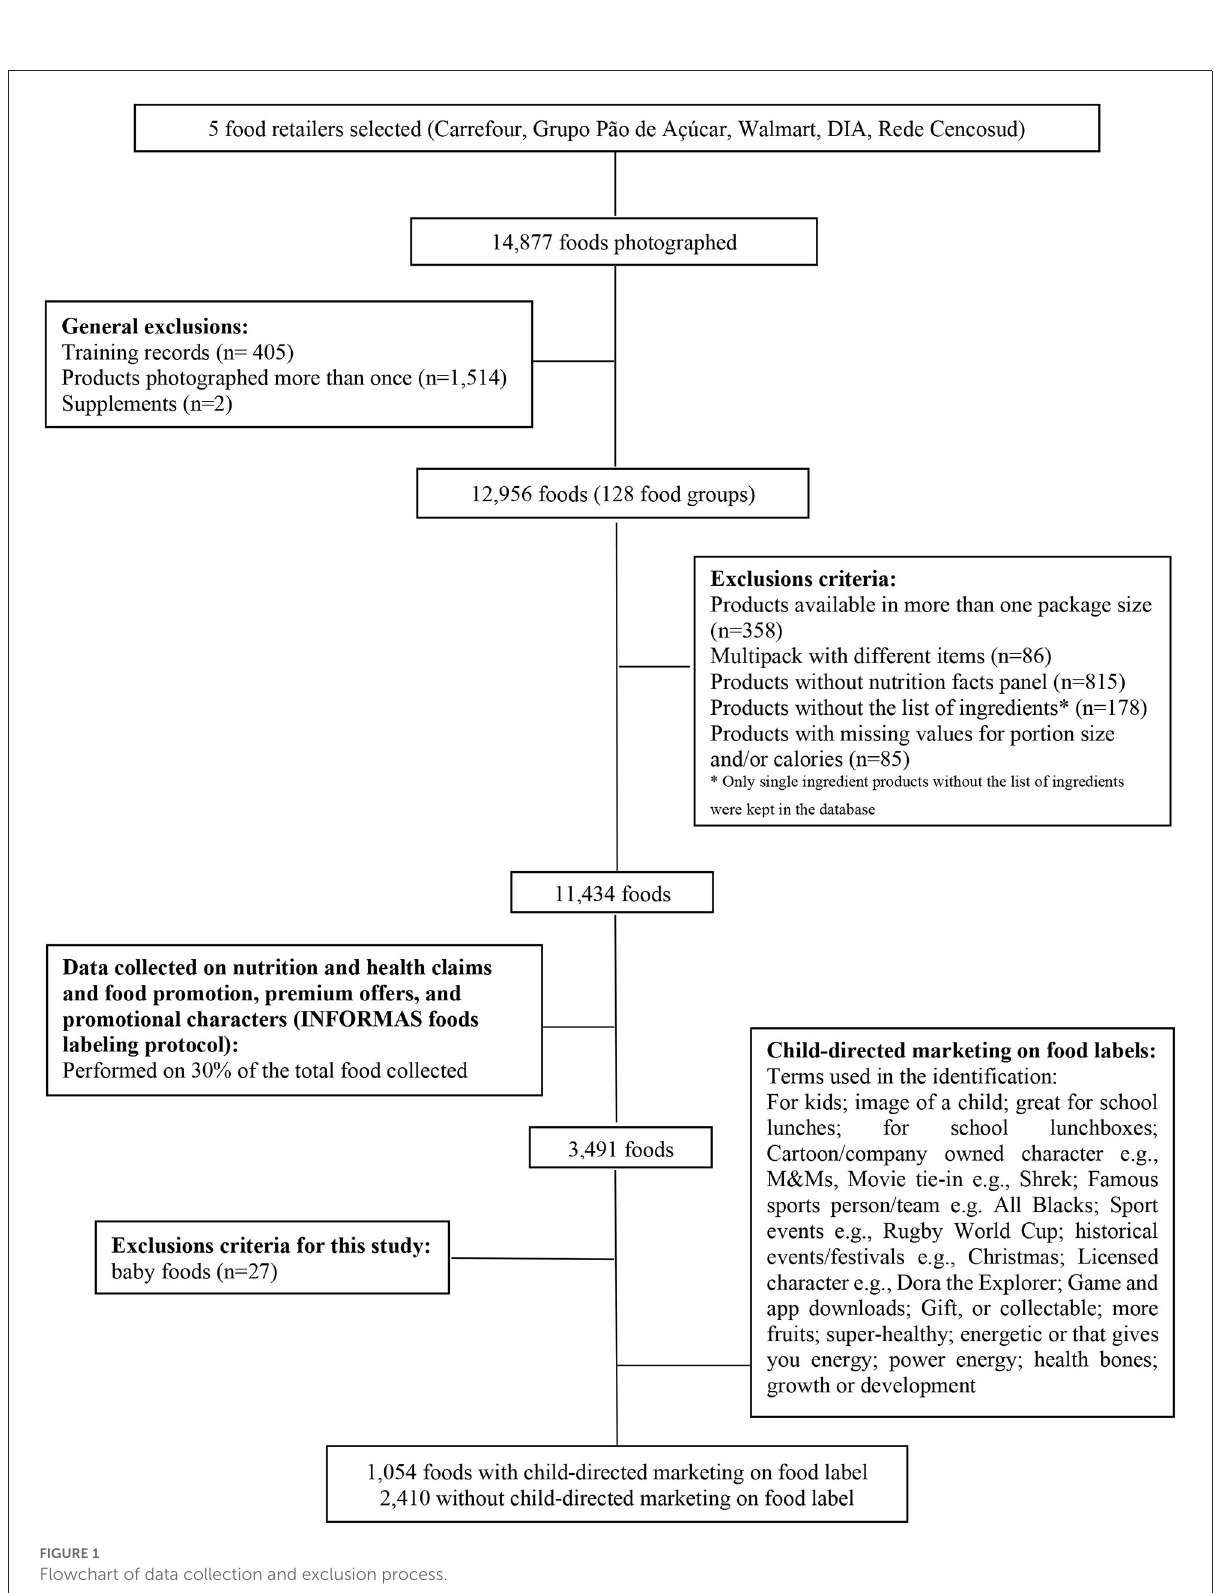
FIGURE1 Flowchart of data collection and exclusion